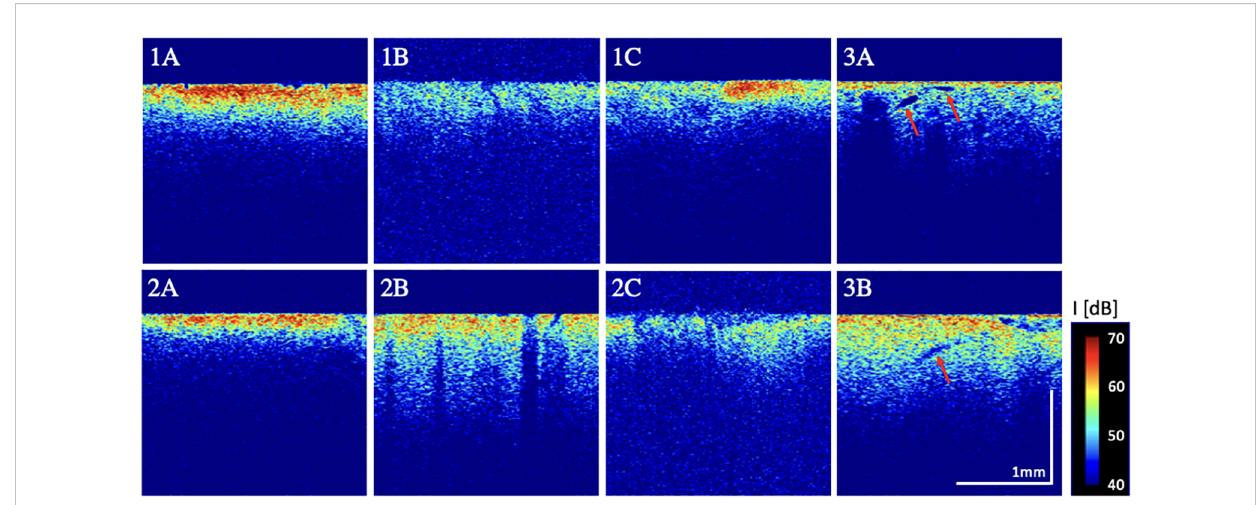
FIGURE 1 Examples of qualitative image properties. 1A: high + homogenous signal intensity, 1B: low signal intensity 1C: heterogenous intensity; 2A: low + uniform penetration depth, 2B: high penetration depth and 2C: non-uniform penetration depths; 3A/3B: increase in microstructures (here, presumably hypervascularization, pointed out through red